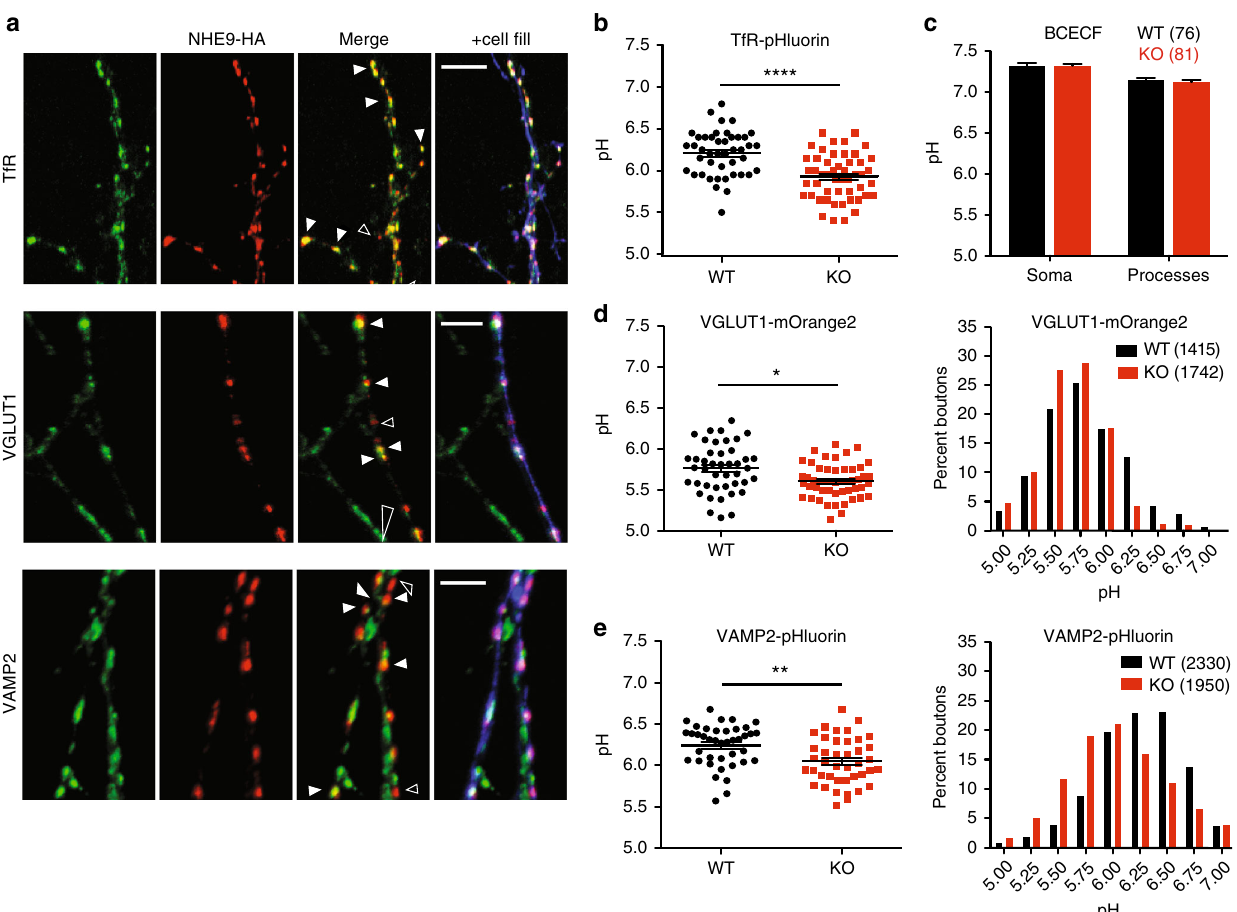
Fig. 3 Loss of NHE9 dysregulates the pH of dendritic and axonal endosomes. a Dissociated hippocampal cultures prepared from NHE9 KO mice were co- transfected with HA-tagged mouse NHE9 and EGFP (to identify the transfected neurons). NHE9-HA colocalizes strongly with the transferrin receptor (TfR) in dendritic endosomes (Manders coef fi cient for TfR/HA 0.76 ± 0.07 s.e.m., Figure S3). In axons, NHE9-HA colocalizes with the vesicular glutamate transporter VGLUT1 at some but not all boutons (Manders coef fi cient for VGLUT1/HA 0.56 ± 0.04 s.e.m. Figure S3). Filled white arrowheads indicate colocalization and un fi lled arrowheads HA-NHE9 alone. Scale bars all indicate 5 μ m. b TfR-pHluorin was transfected into hippocampal neurons and imaged at DIV12 – 14. Dendritic endosomes expressing TfR-pHluorin exhibit a lower pH in NHE9 KO neurons than WT. **** p < 0.0001 by unpaired two-tailed Student ’ s t test. WT, n = 41 neurons/3 cultures; KO, n = 41 neurons/3 cultures. c Cytosolic pH was imaged in the soma and processes using the pH- sensitive ratiometric dye BCECF (2'-7'-bis(carboxyethyl)-5(6)-carboxy fl uorescein). A calibration curve for the dye performed in live neurons (Figure S4) was used to calculate pH. Bars indicate mean ± s.e.m. WT, n = 76 neurons/3 cultures; KO, n = 81 neurons/3 cultures. d VGLUT1-mOrange2 was transfected into hippocampal neurons and imaged at DIV12 – 14. Boutons containing VGLUT1-mOrange2 exhibit a lower average pH in NHE9 KO neurons than WT. * p < 0.05 by unpaired two-tailed Student ’ s t test. WT, n = 43 neurons/3 cultures; KO, n = 50 neurons/3 cultures (left panel). Frequency distribution (right panel) of average pH/ bouton for all boutons analyzed in the study, WT, n = 1415 boutons/3 cultures; KO, n = 1742 boutons/3 cultures. e Boutons expressing VAMP2-pHluorin exhibit a lower average lumenal pH in NHE9 KO neurons than WT. ** p < 0.01 by unpaired two-tailed Student ’ s t test. WT, n = 40 neurons/3 cultures; KO, n = 41 neurons/3 cultures (left panel). Frequency distribution (right panel) of average pH/punctae for all punctae analyzed in the study, WT, n = 2330 boutons/3 cultures; KO, n = 1950 boutons/3